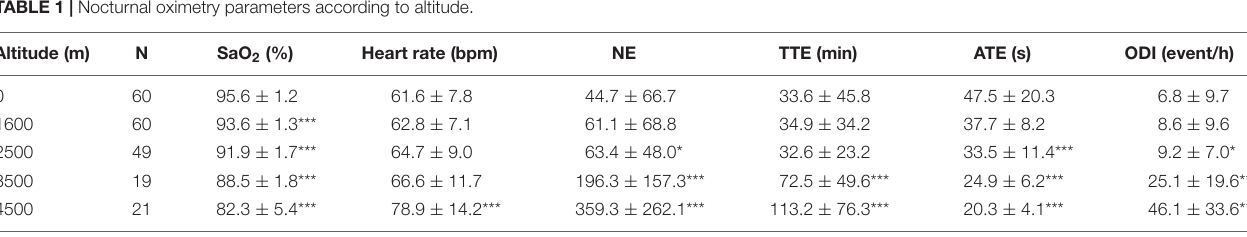
TABLE 1 | Nocturnal oximetry parameters according to